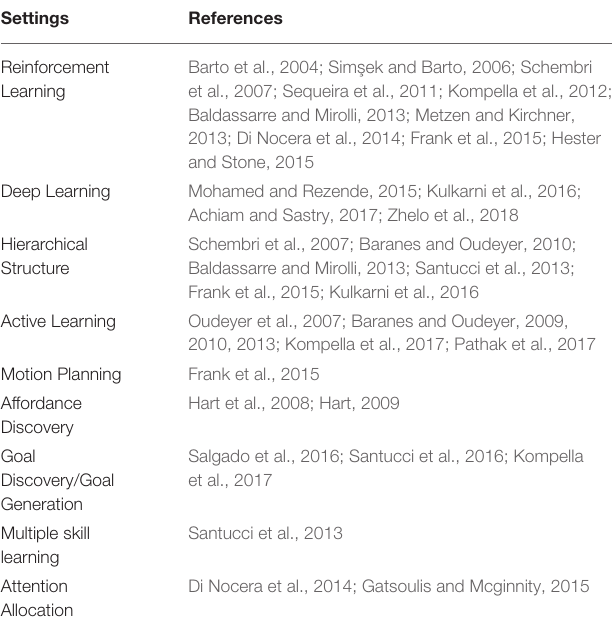
TABLE 2 | Settings in which computational models of motivation are used.